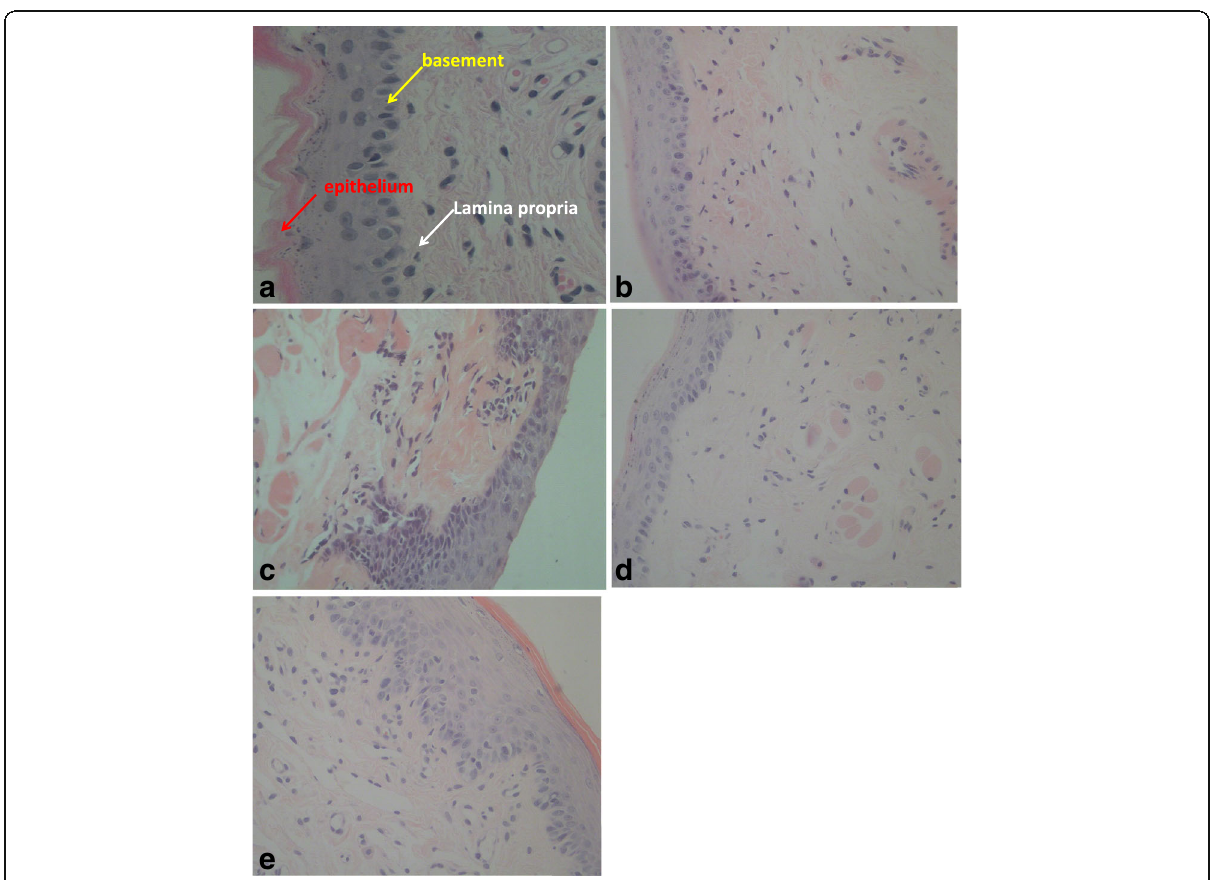
Fig. 1 Histological changes in the oral mucosa of ROU rats (HE, 40× magnification). a , model group; b , PA group; c , low-dose FDPGLM group; d , middle-dose FDPGLM group; e , high-dose FDPGLM group